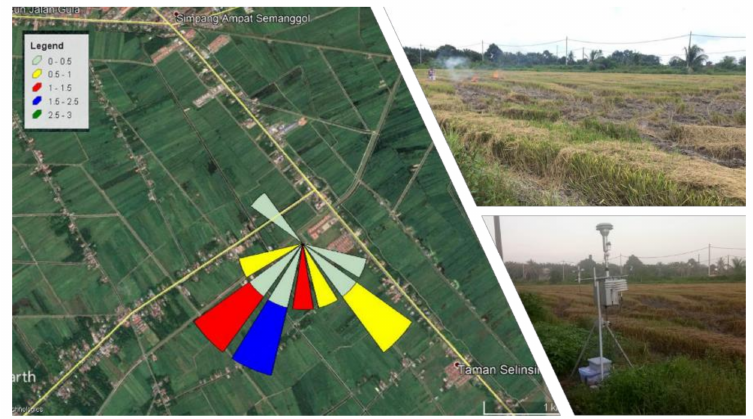
Figure 4. Wind rose plot, blowing from 12 h at Site 1.